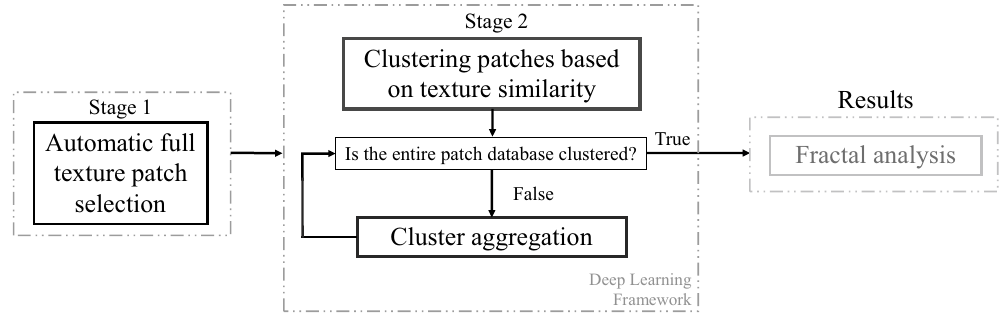
Figure 1. Flowchart of the proposed approach for automatic DEM texture analysis using deep learning. The texture analysis is based on two stages: (1) automatic selection of patches that observe rich texture along the database and (2) using DenseNet to determine clusters that present texture similarity. The fractality degree of each cluster is verified through LCFD